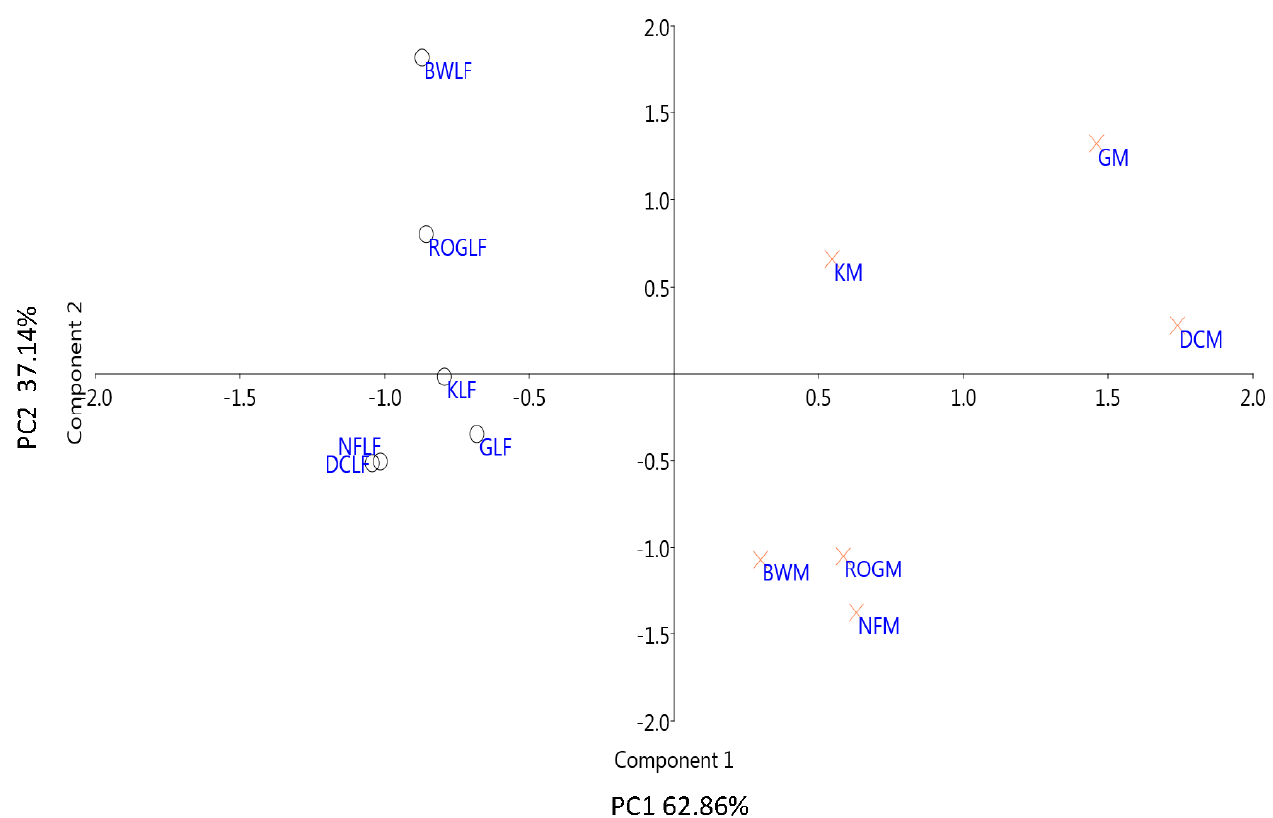
Figure 2. PCA plot showing the distribution of soil samples along with the two principal components. Samples ROGLF, BWLF, and NFLF are from the UK. Samples DCLF, GLF, and KLF come from Ireland. All of them represent the soil LF layer and scatter on the left side of the plot. Mineral samples from the UK (ROGM, BWM, and NFM) appear concentrated in the quadrant limited by the positive x and negative y -axis. Mineral samples from Ireland (DCM, GM, and KM) scatter along the positive x and y-axis quadrant.